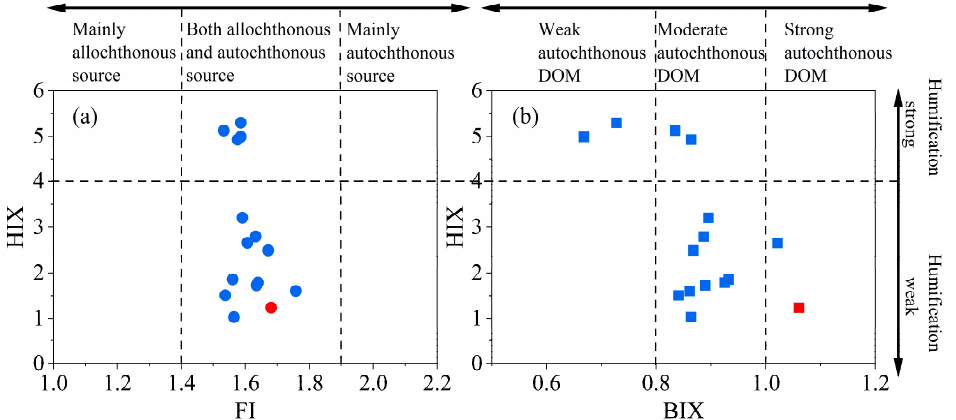
Figure 6. Fluorescence indexes of ( a ) FI and HIX ( b ) FI and BIX of DOM of sediments. The blue points refer to urban sampling sites, and the red ones were the reference.